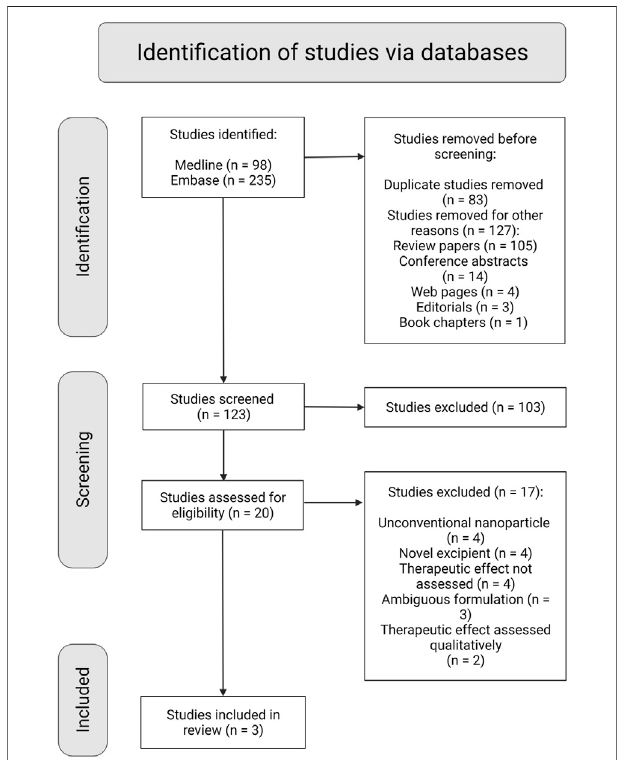
FIGURE 2 | PRISMA fl ow diagram with schematic representation of the screening and selection process of studies retrieved from the systematic search (Created with